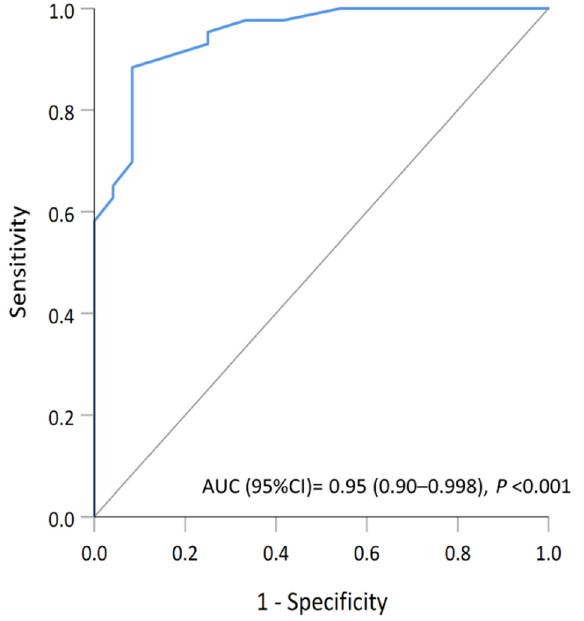
Figure 4. The analysis of the receiving operating characteristics curve demonstrating the ability of the combined predictive model (dMMR phenotype, pRb expression and lack of CDK4 or CDK6) to discriminate the DPC group.